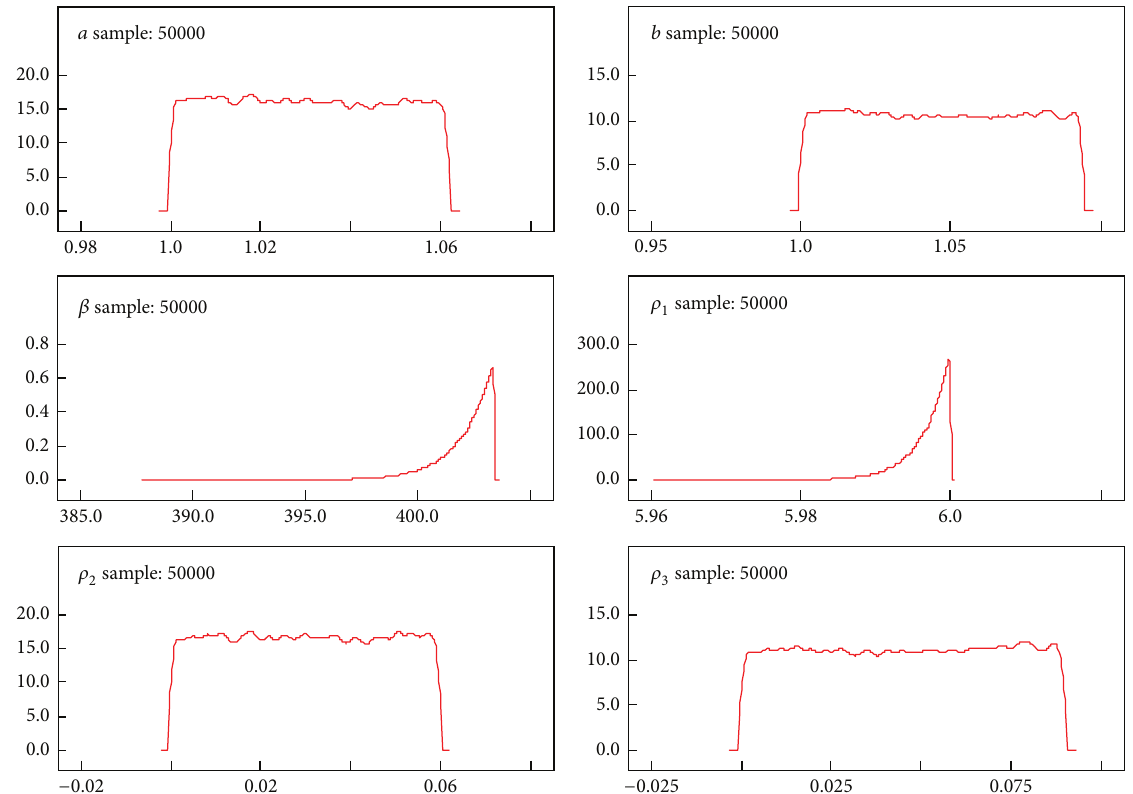
Figure 6: Kernel density of the posterior parameters in the case of BIW for Black Hispanic females breast cancer patients ( 𝑛 = 298 ).